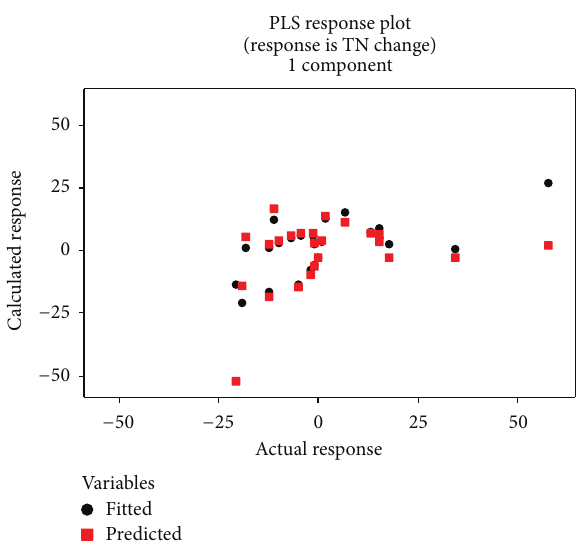
Figure 11: Scatter plot of the fitted and cross-validated data versus the actual TP